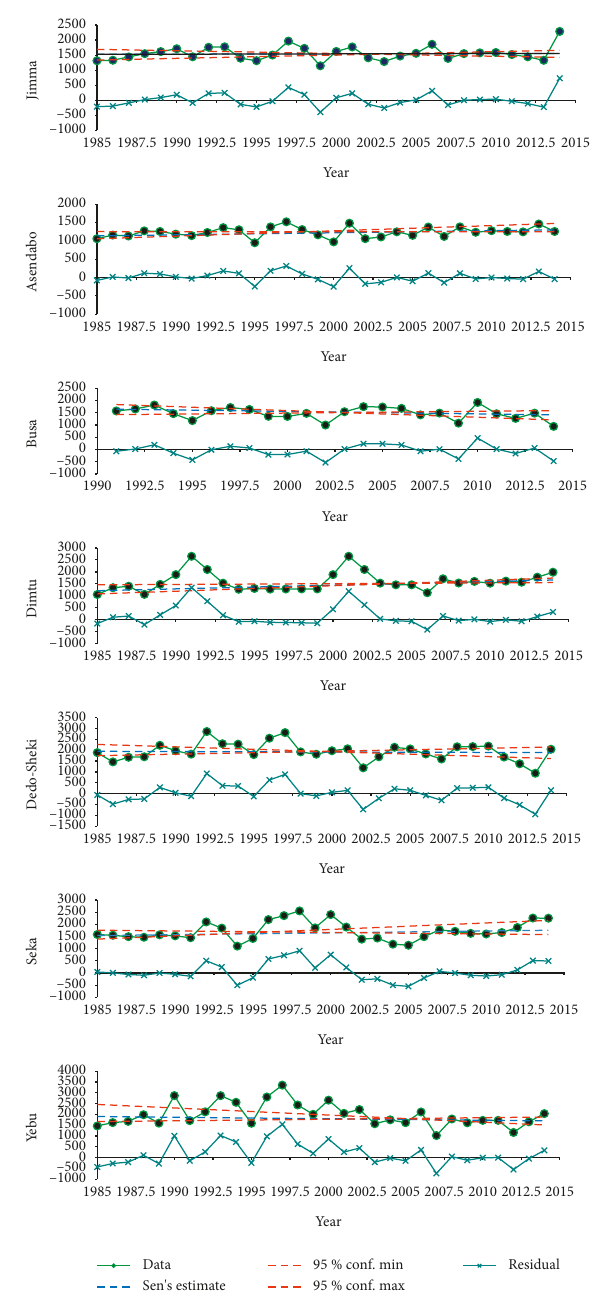
Figure 3: Trends in rainfall data at seven (7) stations in/around Gilgel Gibe river